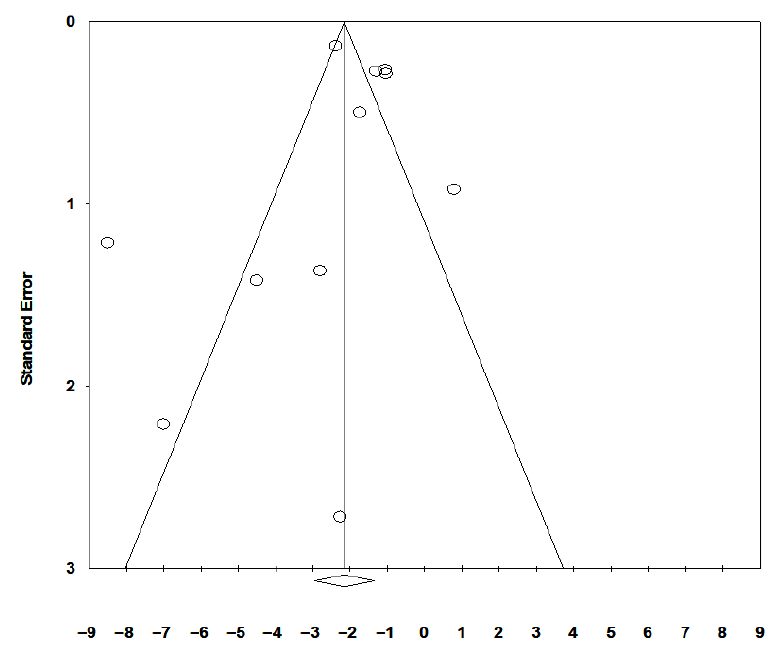
Figure 2. Forest plot showing mean differences in serum 25-hydroxyvitamin D (25-OH-D) levels (ng/mL) in shift workers and non-shift workers [12,24–35].